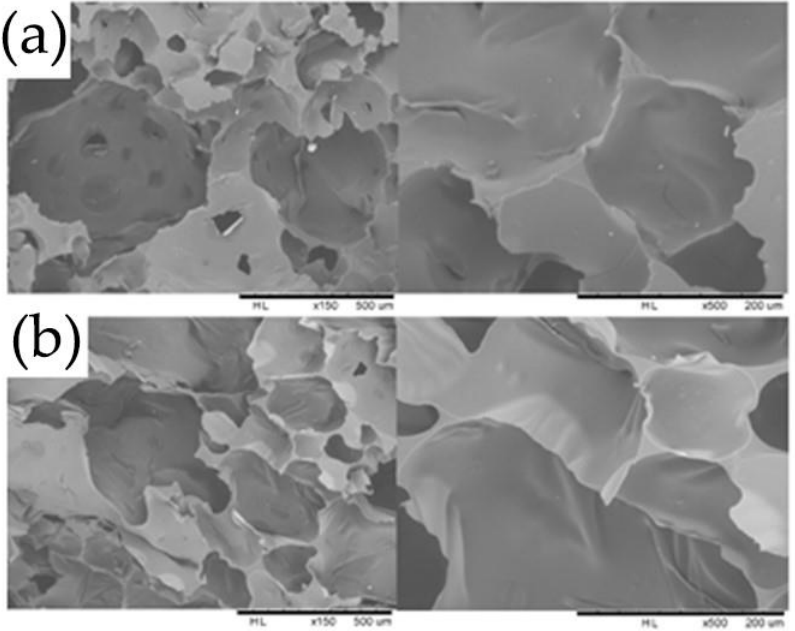
Figure 9. Effect on foam morphology of small difference proportions of furfuryl alcohol (FA): ( a ) F-H5.9-FA5-W1.5; ( b ) F-H5.5-FA6-W1.5.